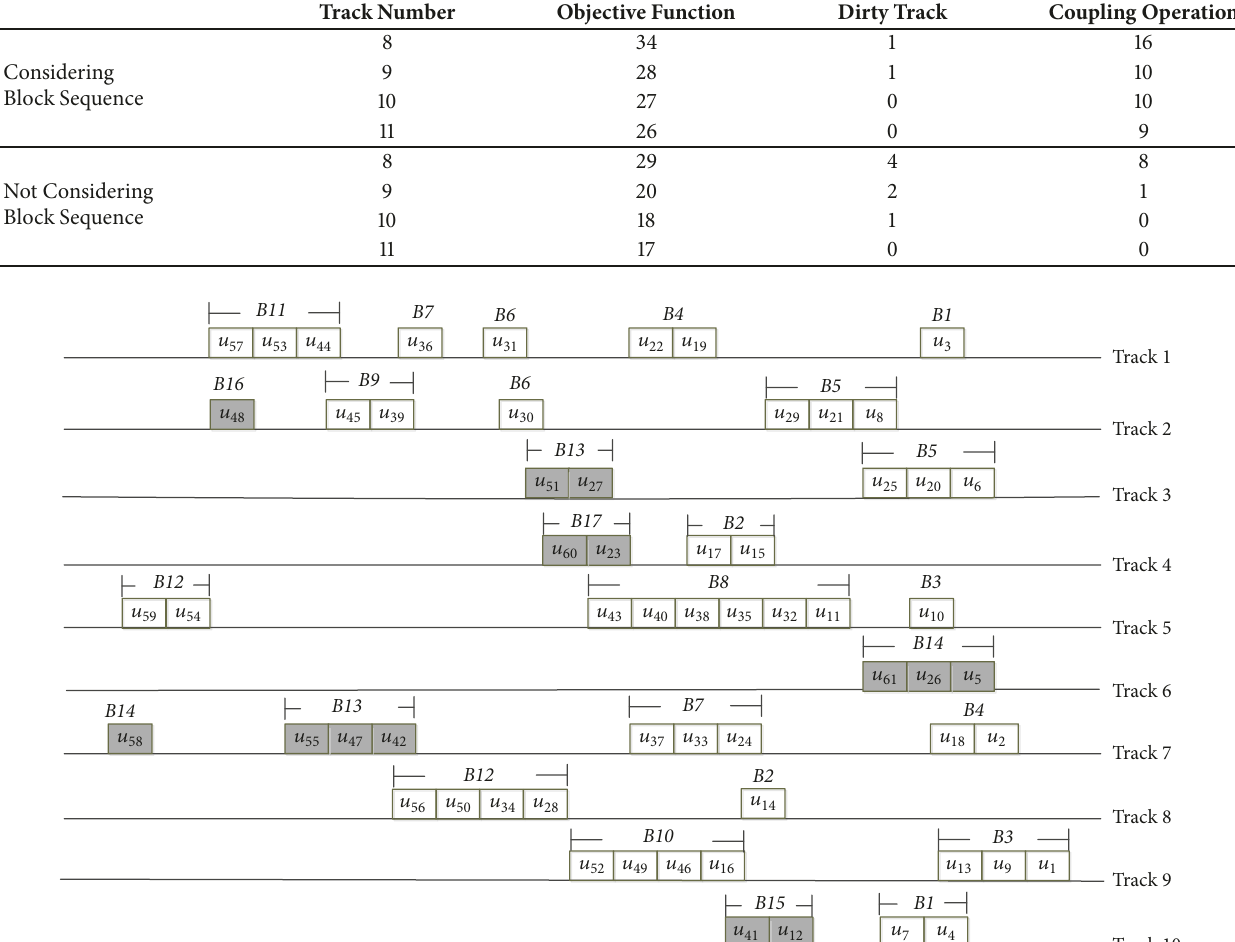
Table 5: Comparison of the results for whether to consider the block sequence.